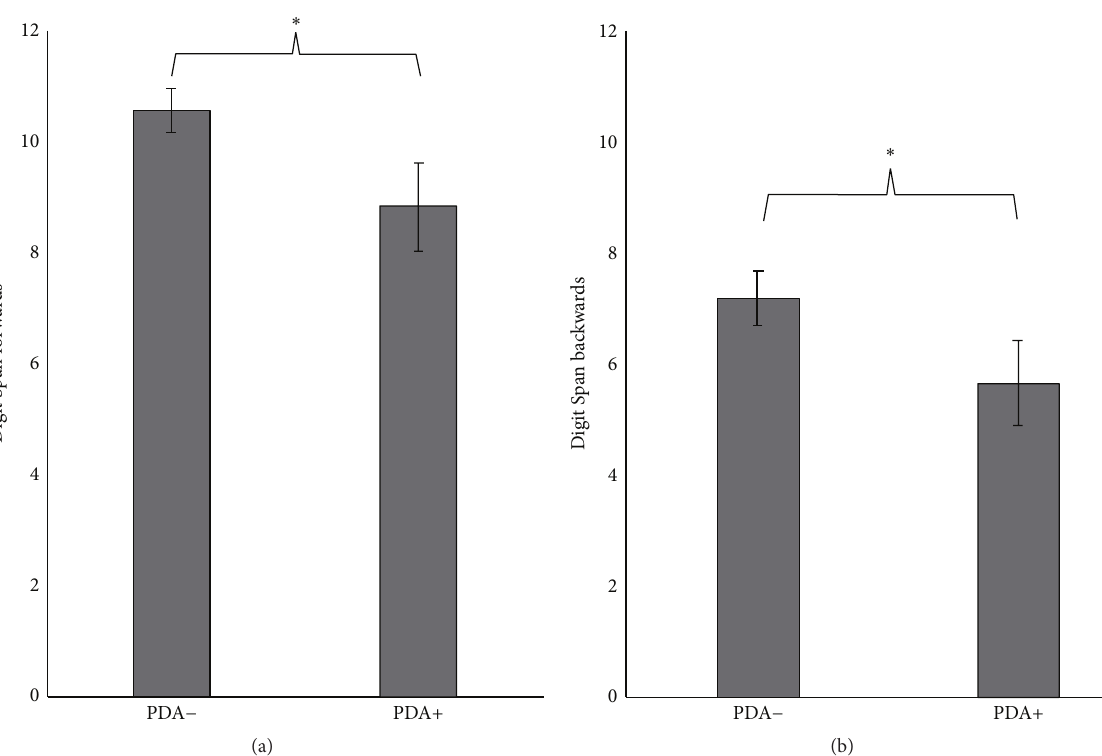
Figure 2: PD patients with anxiety performed significantly worse on the Digit Span forward (a) and backward (b) test compared to PD patients without anxiety. ∗ denotes 𝑝 values < 0.05. Error bars represent standard error of the